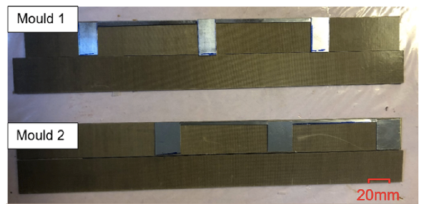
Figure 3. Image of the manufactured